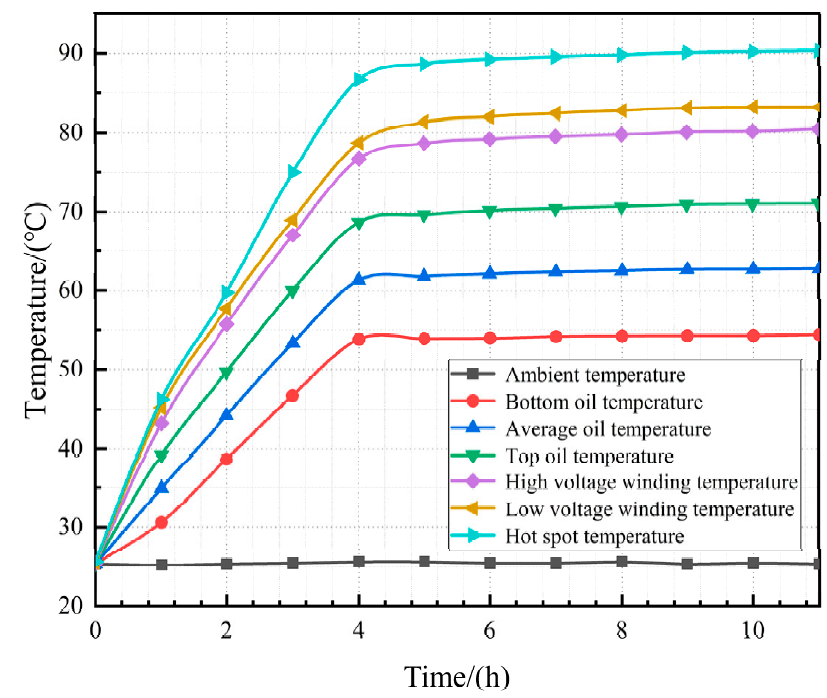
Figure 9. The test data of temperature rise. Table 3. Temperature rise calculated results and test data.